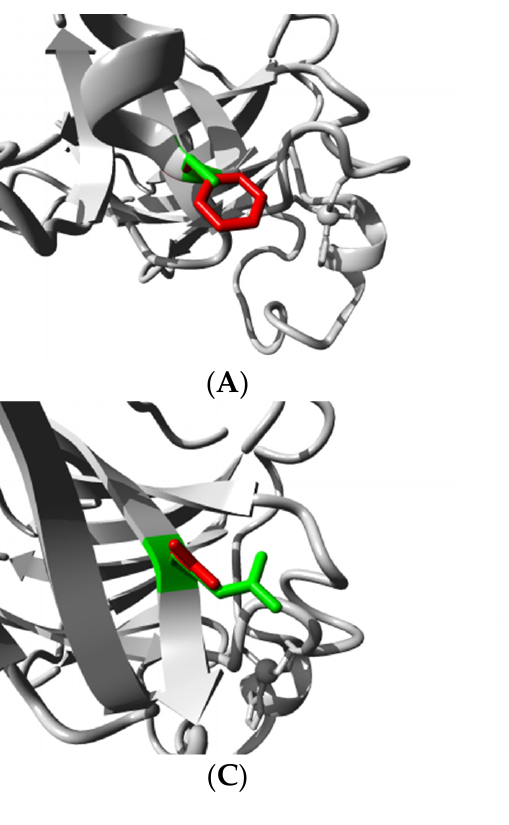
Figure 4. ( A ) Conservation analysis of nsSNPs using ConSurf. ( B ) Distribution of high-risk nsSNPs of TP63.